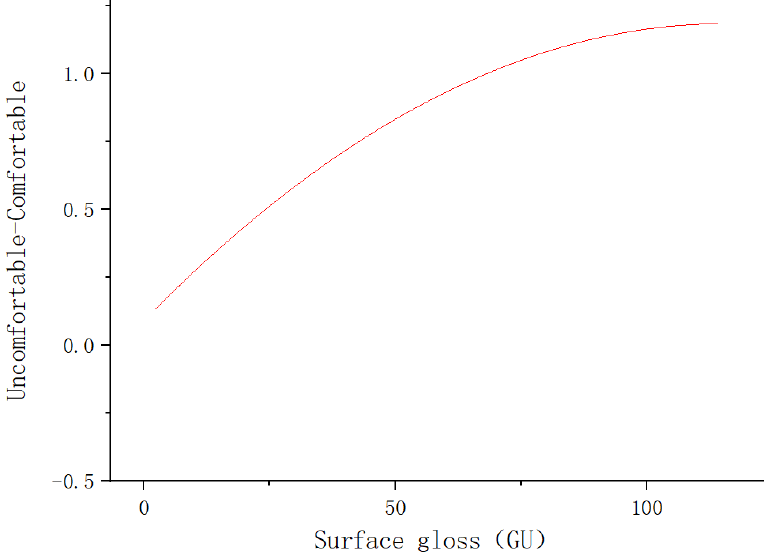
Figure 17. “Uncomfortable-Comfortable” and surface gloss polynomial fitting function.